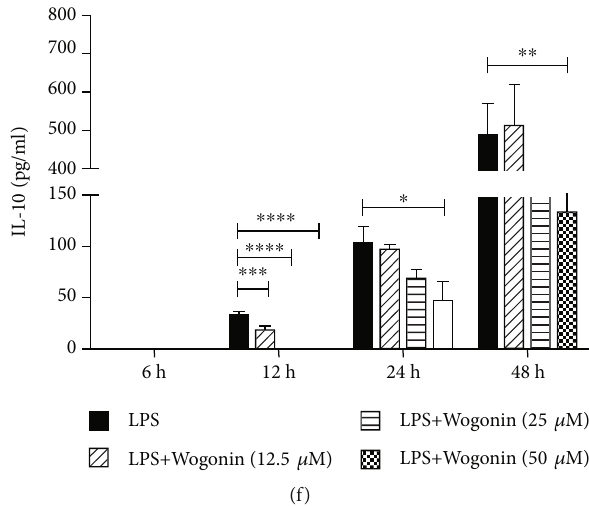
Figure 2: Wogonin suppressed the production of IL-10 in LPS-induced B cells. The puri fi ed CD19 + cells from the spleen were stimulated with or without LPS in the presence or absence of Wogonin (0, 12.5, 25, 50, and 100 μ M) for 6h, 12 h, 24 h, and 48 h, and the frequencies of IL-10- producing B cells were analyzed. (a) Representative plots of IL-10-producing B cells with LPS induced in the presence or absence of Wogonin. (b – e) Quanti fi cation and MFI of IL-10-producing B cells at 6h, 12 h, 24h, and 48h, respectively. (f) The supernatants from the di ff erent culture conditions were assayed by ELISA for the production of IL-10. Data are expressed as mean ± SD of three independent experiments and compared with one-way ANOVA. ∗ P < 0 : 05 ; ∗∗ P < 0 : 01 ; ∗∗∗ P < 0 : 001 ; ∗∗∗∗ P < 0 : 0001 ; ns: no signi fi